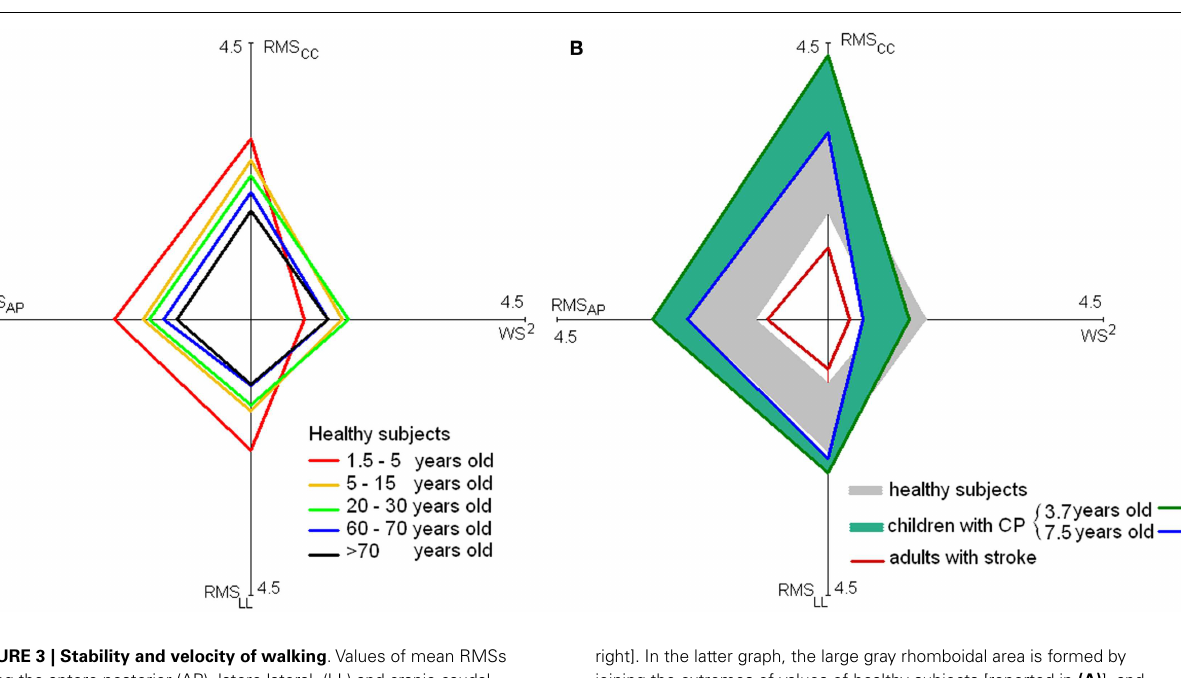
right]. In the latter graph, the large gray rhomboidal area is formed by joining the extremes of values of healthy subjects [reported in (A) ], and blue–green rhomboidal area by joining the extremes of values of children with cerebral